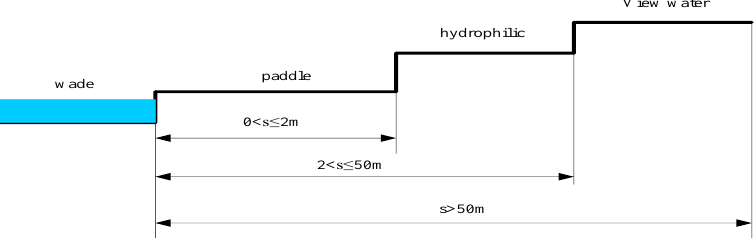
Figure 2. The effect of distance on human hydrophilicity.